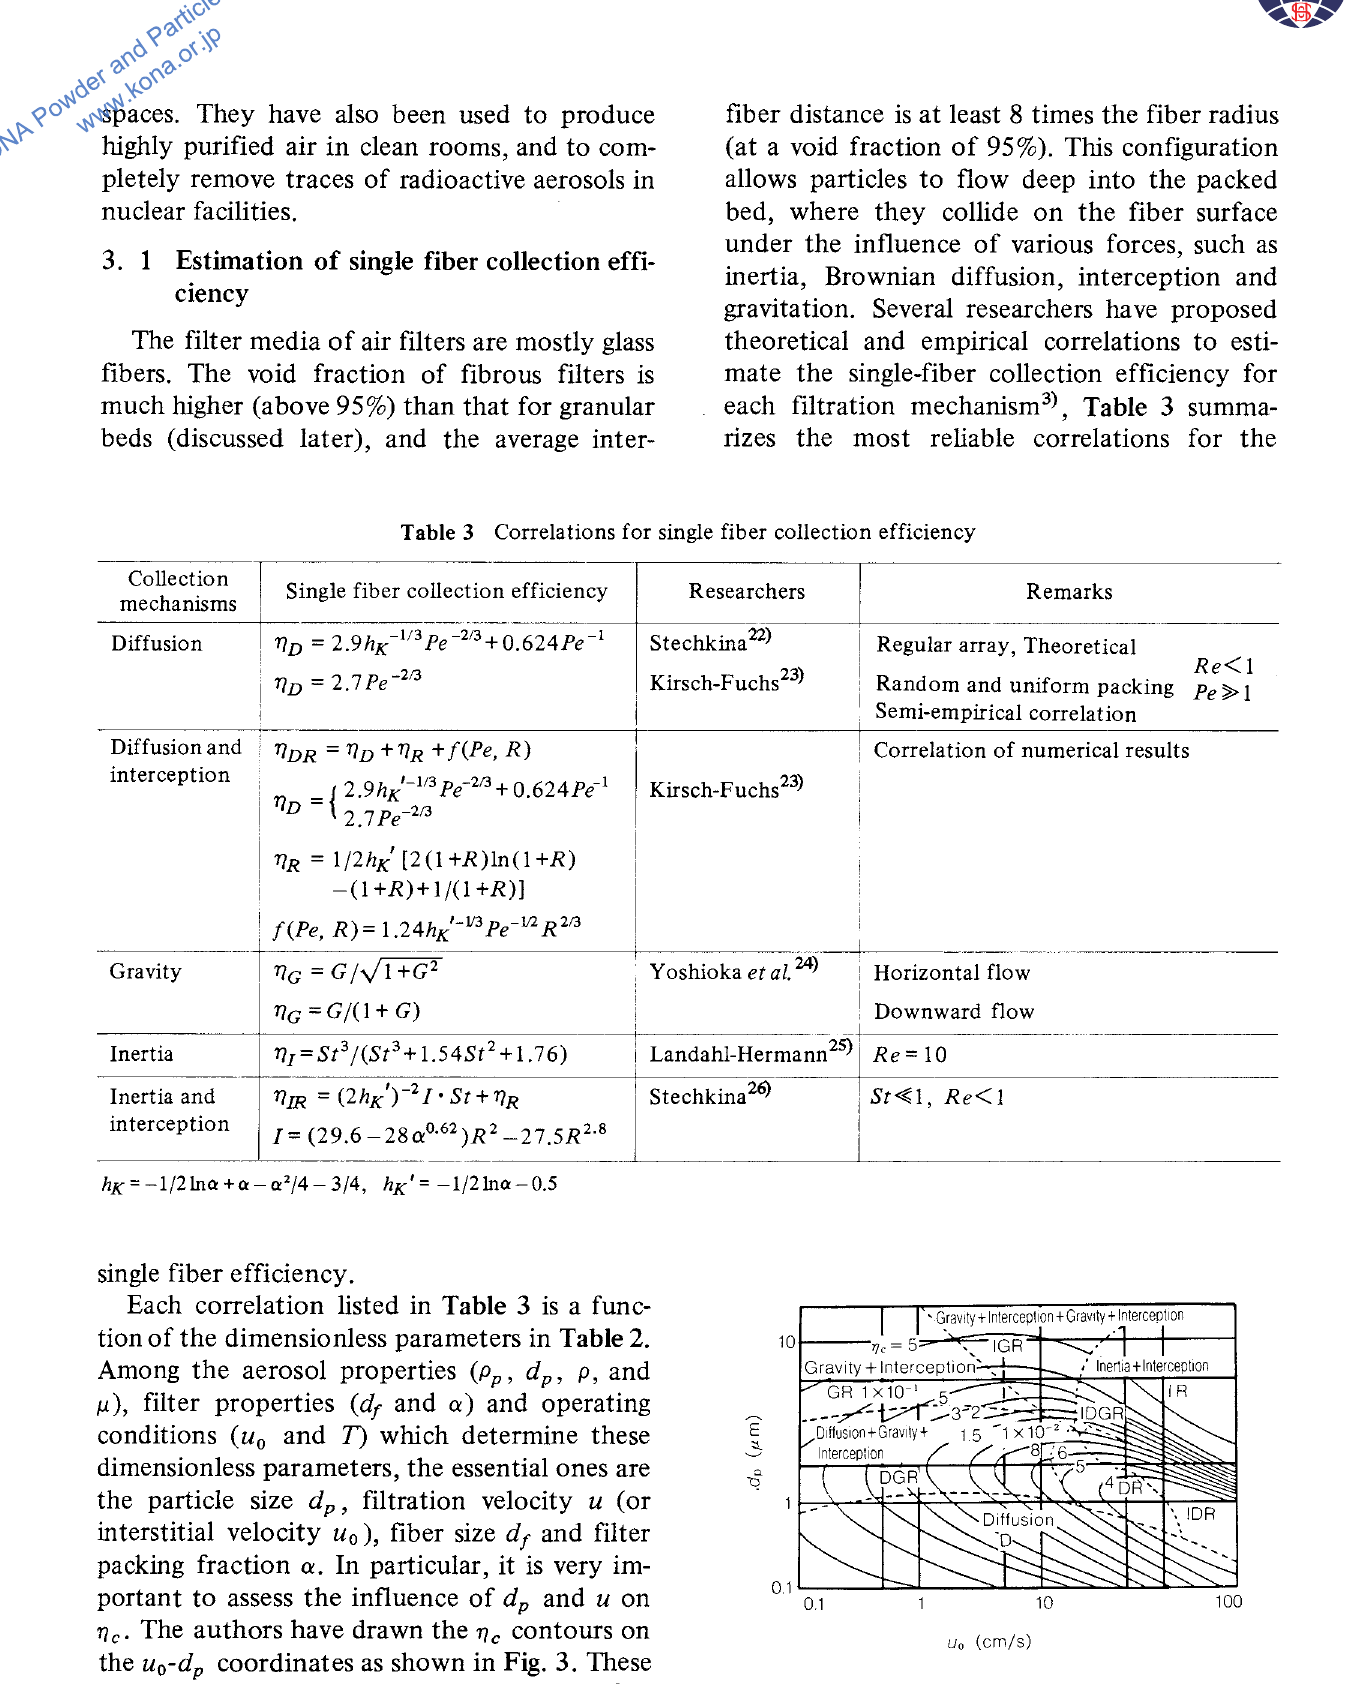
Fig. 3 The regions governed by individual collection mechanisms and contours of single fiber collection